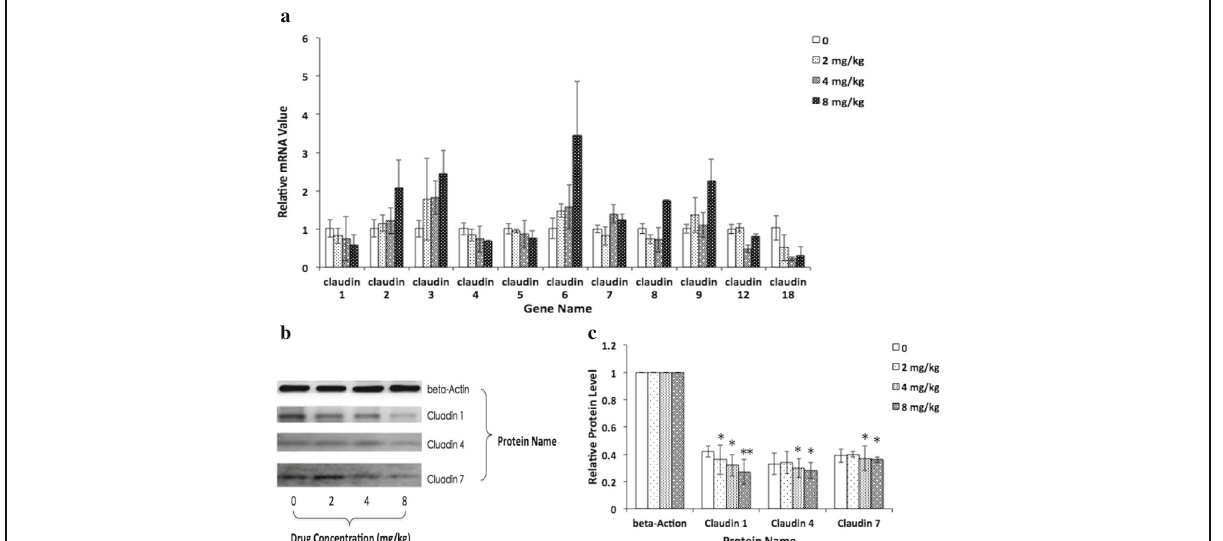
Fig. 15 Claudin family genes and protein relative expressions upon exposure to various concentrations of oridonin for 7 d. a relative gene expression comparison; b protein levels in mouse tumour tissue sections detected by WB; c relative protein expression comparison. The asterisks indicate statistically significant differences from the control group (* P < 0.05, ** P <